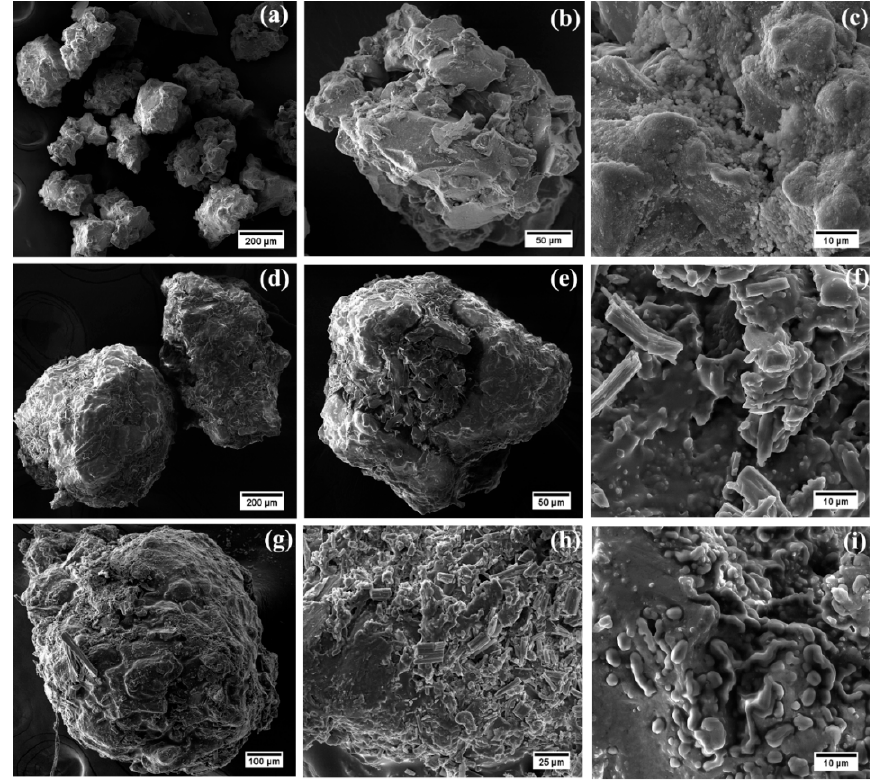
Figure 7. SEM micrograph of the synthesized ( a – c ) PAM ( d – f ) SPAM ( g – i ) DPAM.